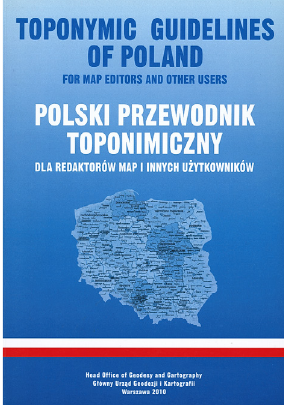
Fig. 6. Cover of Toponymic guidelines of Poland